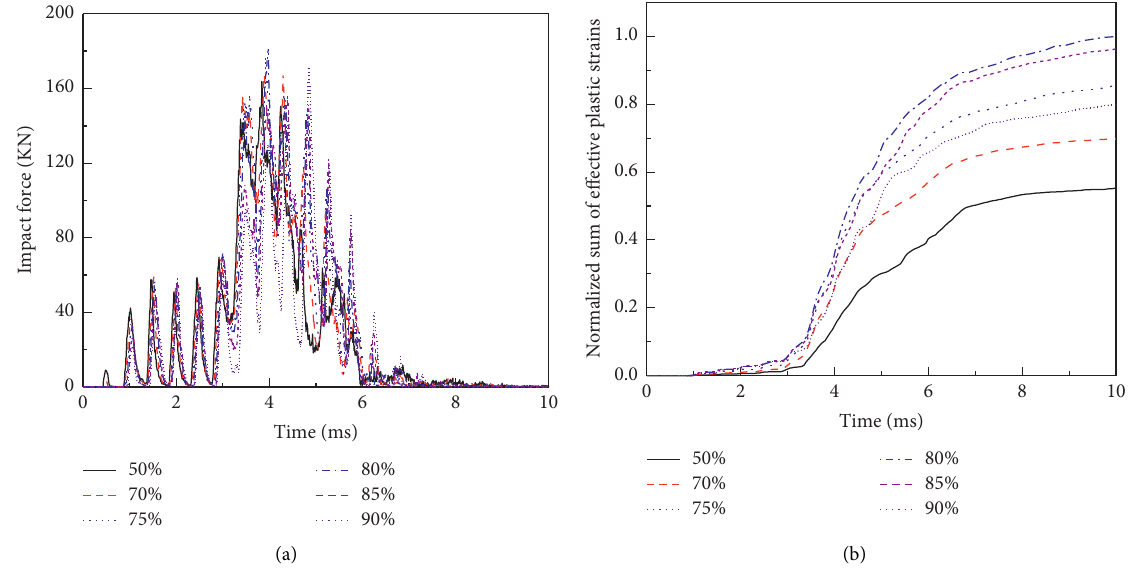
Figure 11: Effect of target location on the impact loading history and blade damage. (a) The impact loading history. (b) Normalized sum of effective plastic